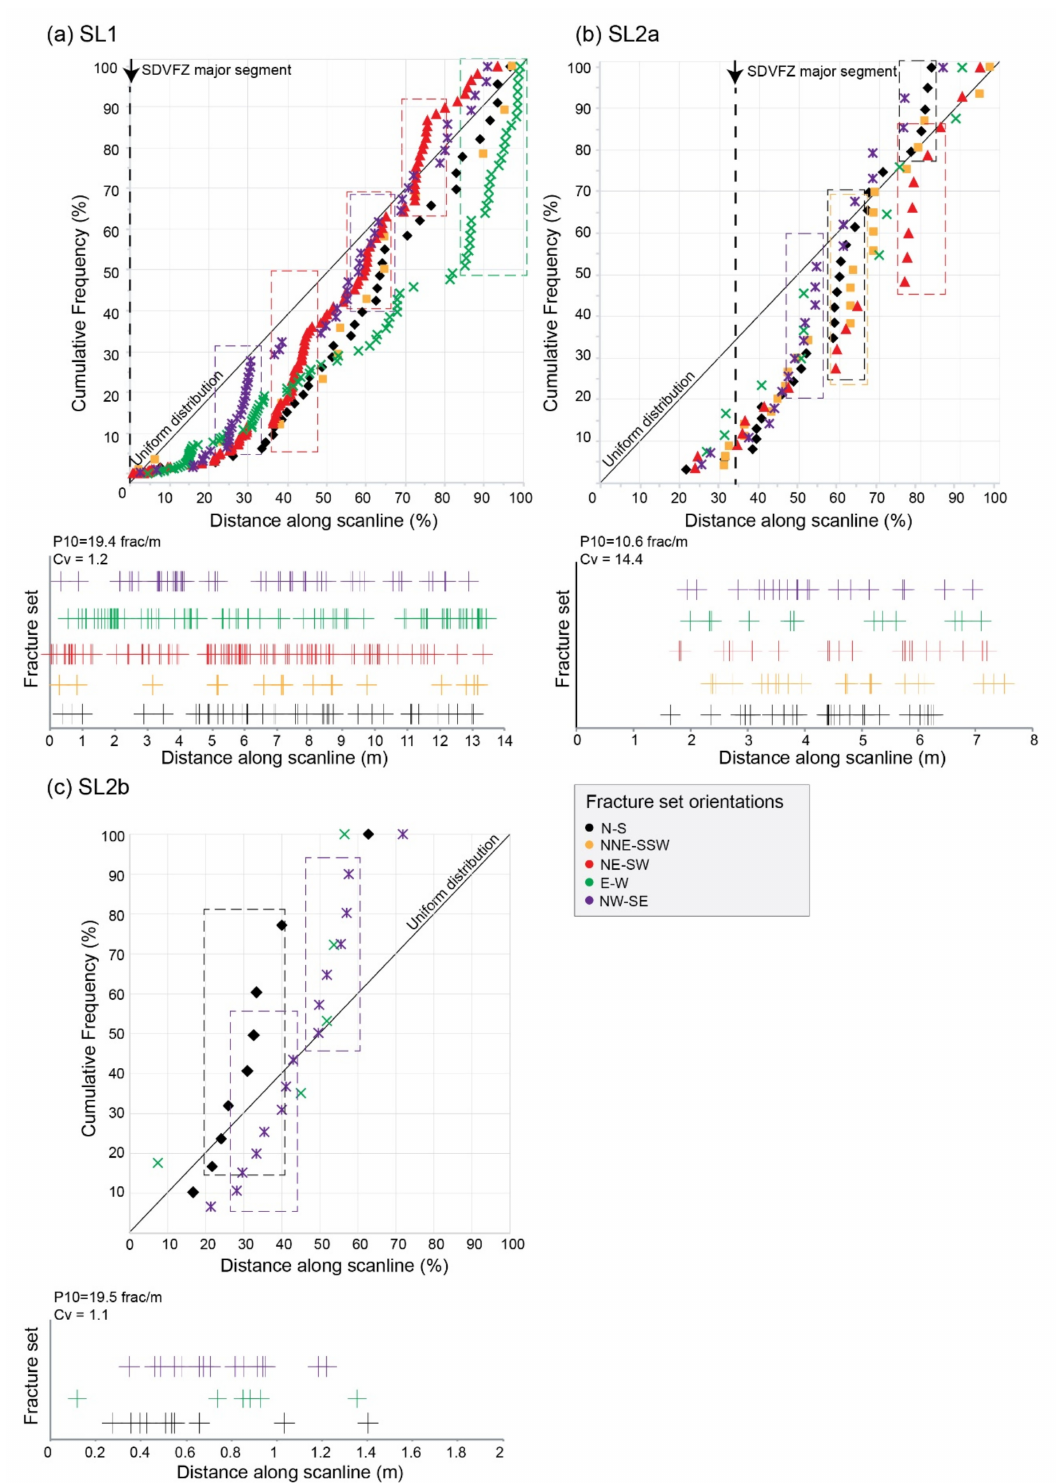
Figure 6. Cumulative frequency diagram along each scanline and following each fracture set (in colors). Plot of cumulative frequency expressed in % versus distance along scanline for: ( a ) SL1, ( b ) SL2a, and ( c ) SL2b. Dashed lines indicate a potential cluster for each fracture distribution, indicating a rapid increase in the number of fractures with slope threshold > 2. The diagonal line in each plot of cumulative frequency defines a uniform or regular distribution. Visual location of fractures expressed in stick plots for each fracture set distribution, highlighting the fracture position along the scanline, including the fracture density (P 10 ) and the coefficient of variation (Cv) values. The structural position is done in each diagram. See the color legend for the orientation of fracture